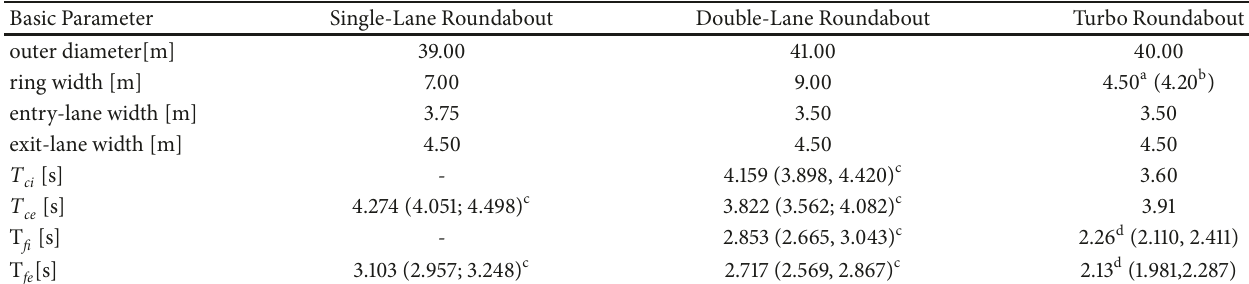
Table 3: Geometric design and behavioural parameters of every roundabout category.